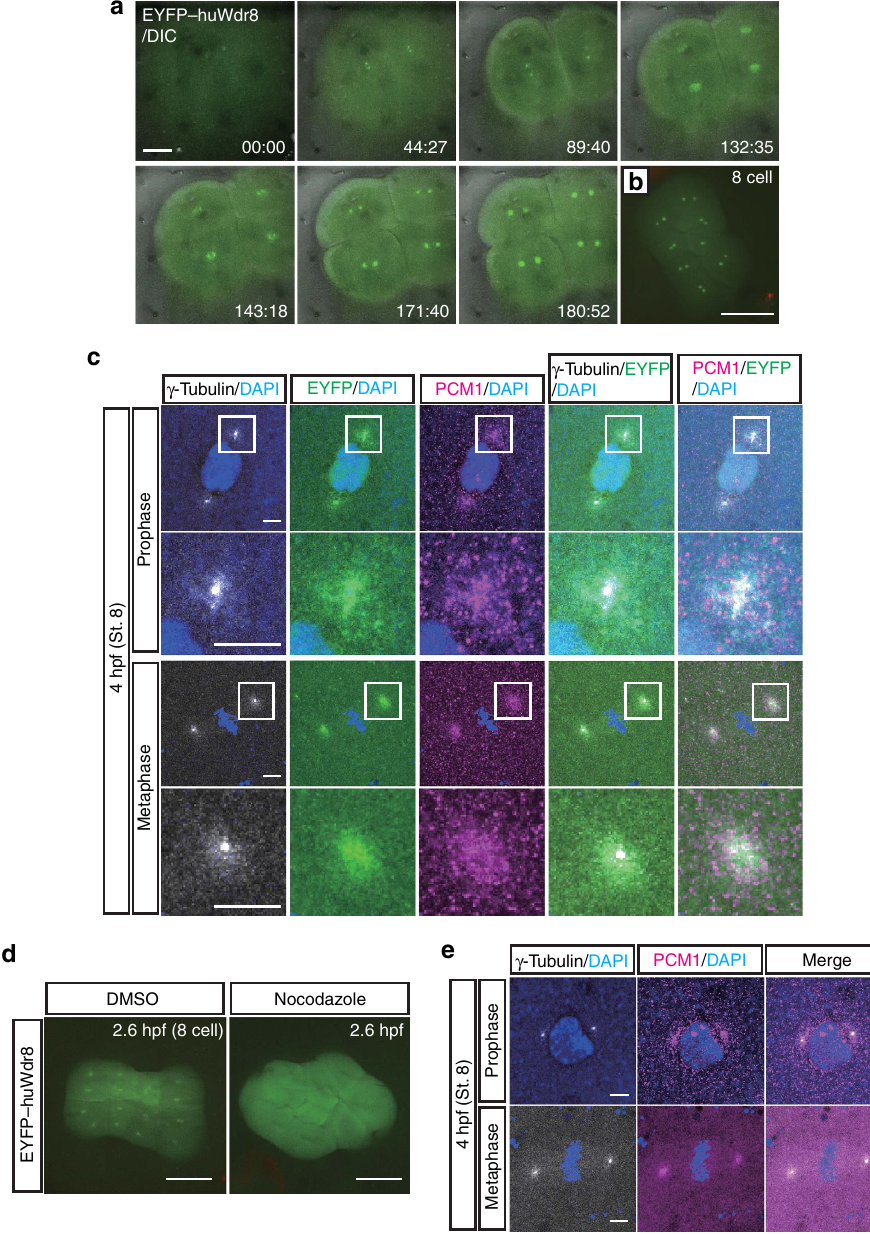
Figure 2 | Wdr8 localises to the centrosome in the rescued Wdr8 (cid:2) / (cid:2) blastomeres. ( a , b ) Spatiotemporal localisation of EYFP–huWdr8 in the rescued Wdr8 (cid:2) / (cid:2) zygotes. Time-lapse images show stereotypic centrosome cycles from one- to four-cell stage ( a ) and 8-cell stage ( b ). Time, min. ( c , e ) Wdr8 is a novel maternal centrosome protein. EYFP–huWdr8 localised next to g -tubulin-positive PCM and co-localised with the CS protein, PCM1 ( c , insets; magnified view of the centrosome), resembling the wild-type situation ( e ). ( d ) Centrosomal EYFP–huWdr8 in the rescued Wdr8 (cid:2) / (cid:2) zygotes dispersed into cytoplasm after nocodazole treatment. Scale bars, 100 m m ( a ), 200 m m ( b , d ), 10 m m ( c , e ). Stages are denoted as hours post fertilisation (hpf) and the corresponding stages of WT are denoted in